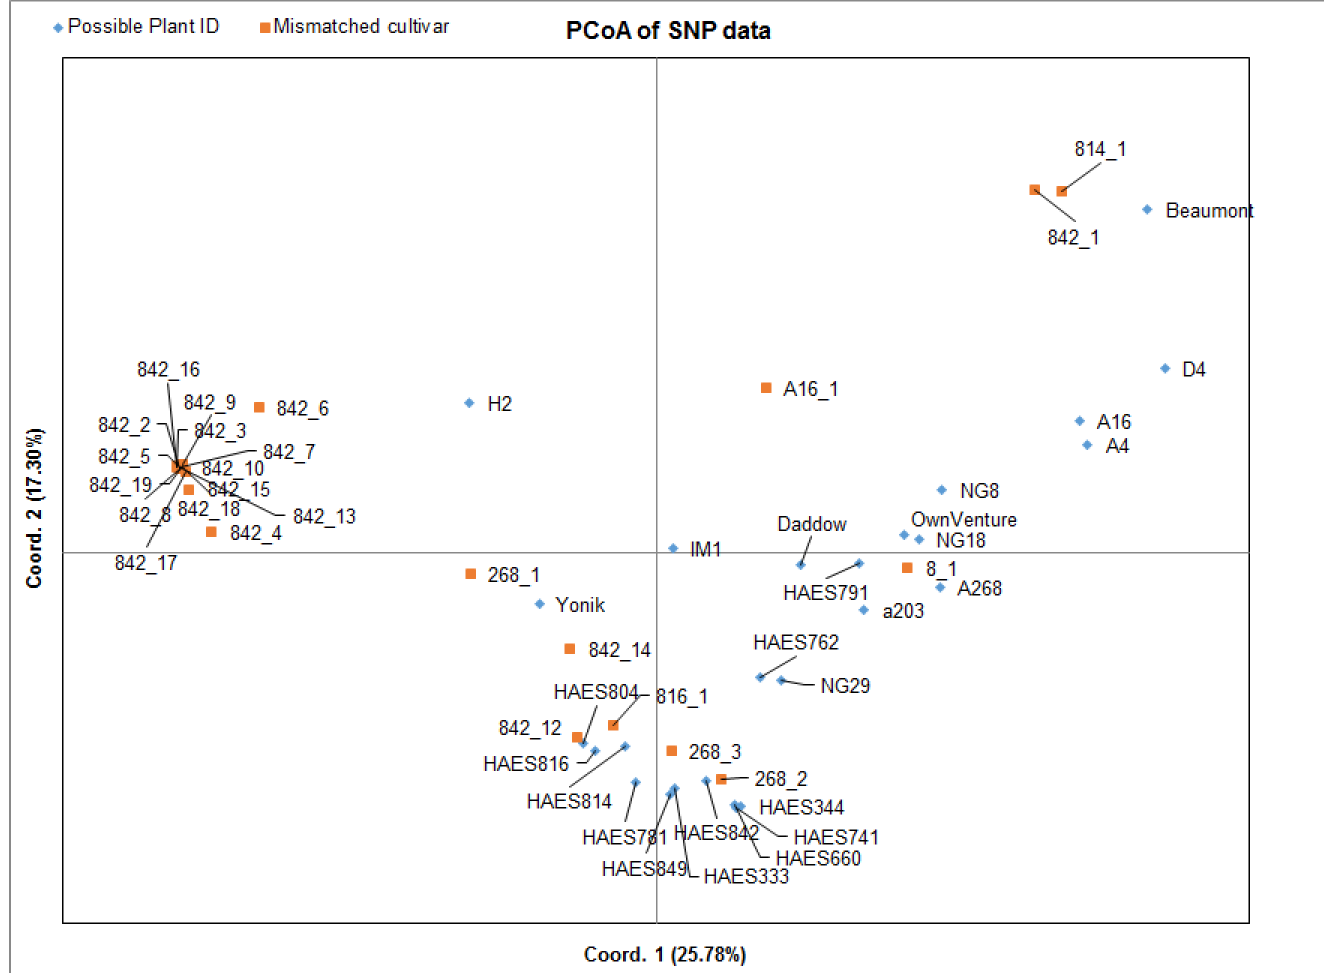
Fig 6. Principal coordinate analysis of SNP markers showing allelic variation among macadamia cultivars and mismatched scions.